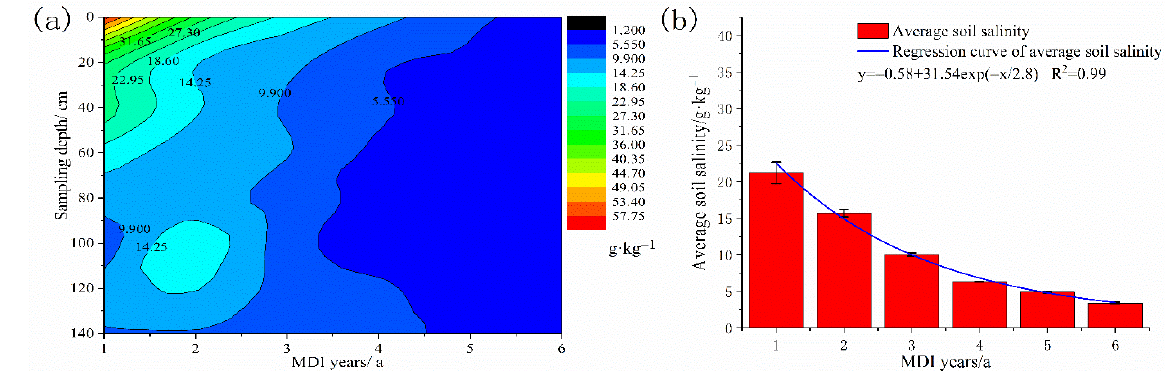
Figure 4. Distribution and variations of soil salinity within 0–140 cm soil layer of the cotton field during 1–6 years applying MDI ( a ). The first-order decay exponential function regression equation of salinity (Value ± SD) and years of applying MDI ( b ).